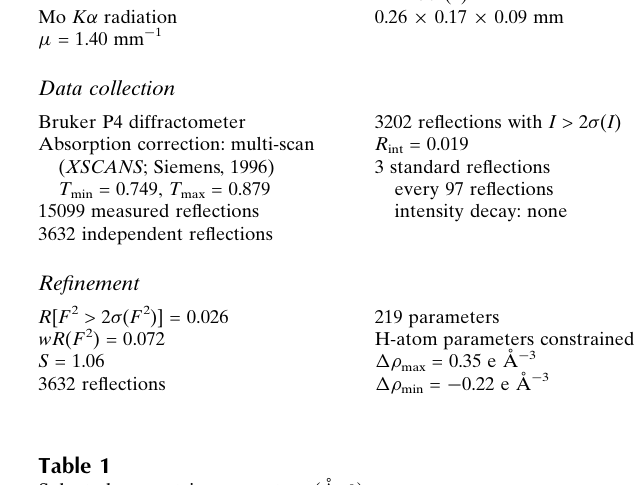
Selected geometric parameters (A˚ , (cid:1) ).